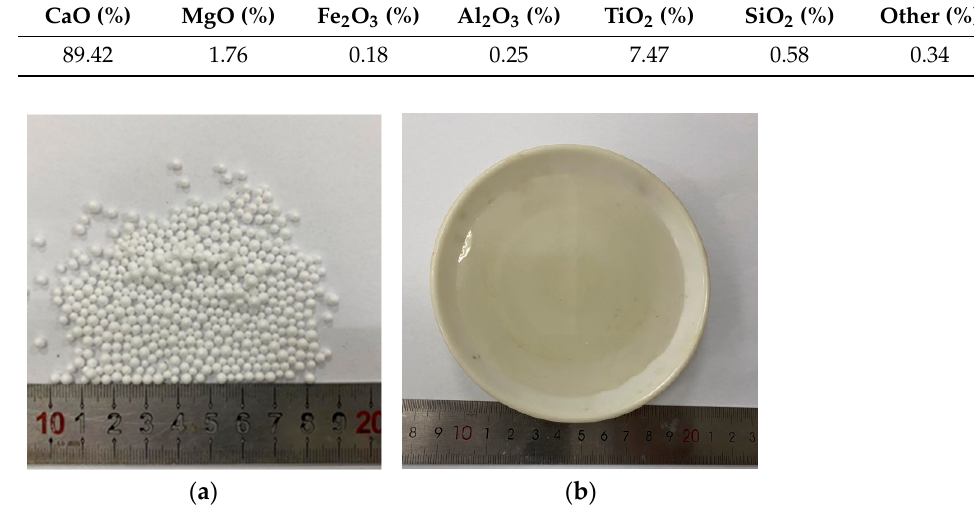
Figure 1. Test material: ( a ) Photograph of EPS particles; ( b ) Sodium silicate solution.